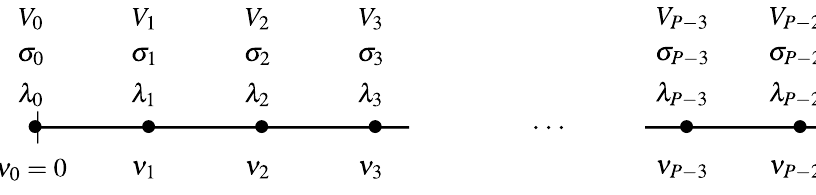
Figure 2. The time nodes ν i where the data values are